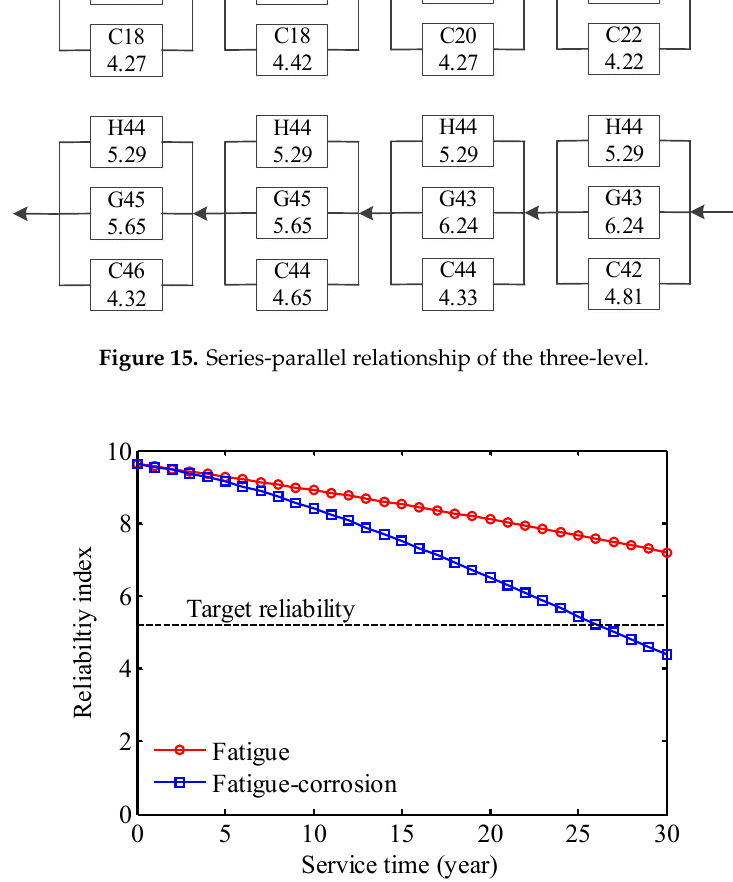
Figure 16. Influence of the cable strength degradation on the system reliability of the suspension bridge.